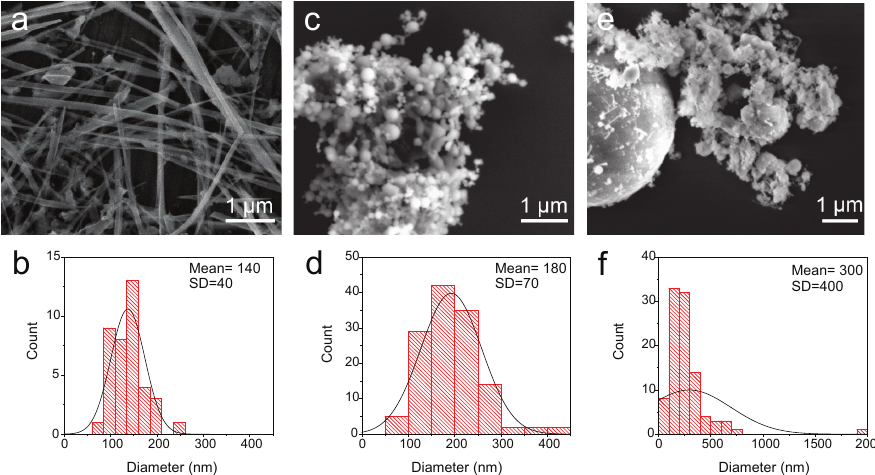
Figure 3. SEM images of MACE SiNWs ( a ), SiNPs from Alpha Aesar ( c ) and SiNWS/SiNPs from US nano ( e ). ( b , d , f ) are the histograms of above-mentioned